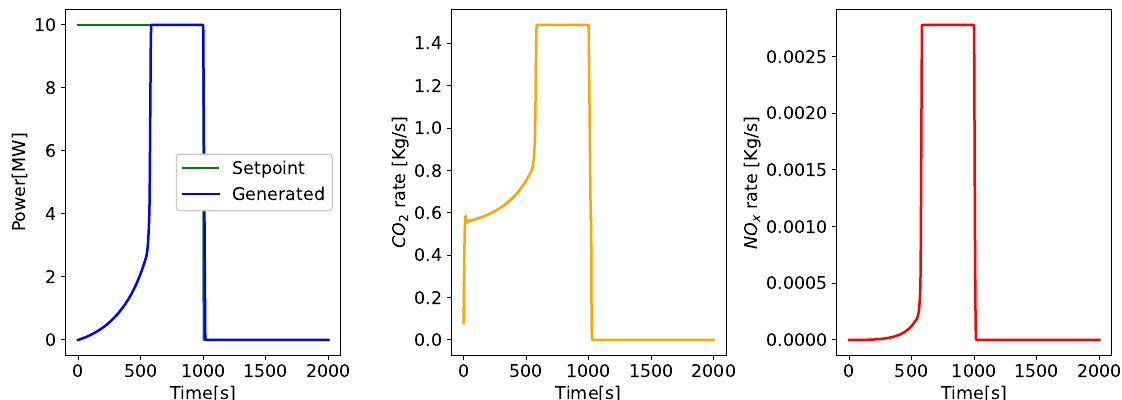
Figure 3. Fastest possible ramp-up of a gas turbine from zero to maximal power output and back to zero and its corresponding greenhouse gas emission